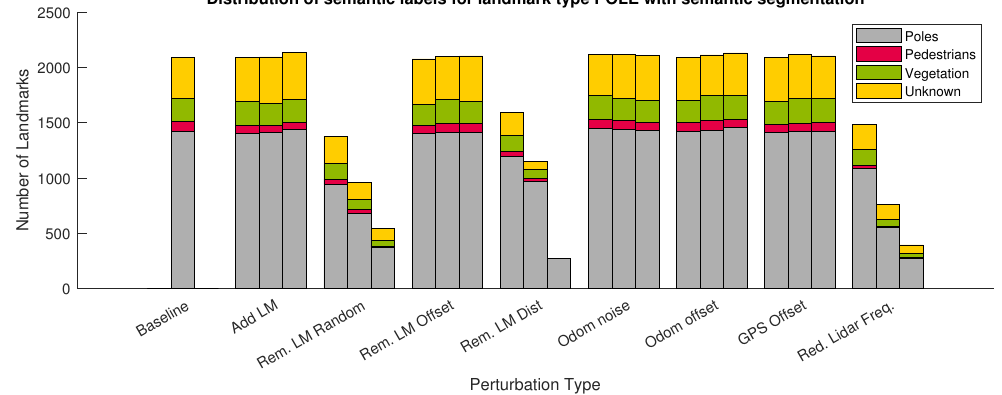
Figure 10. Distribution of class labels added by semantic segmentation for every perturbation injection p and clustered for all three levels of severity s . The baseline performance is displayed on the left for